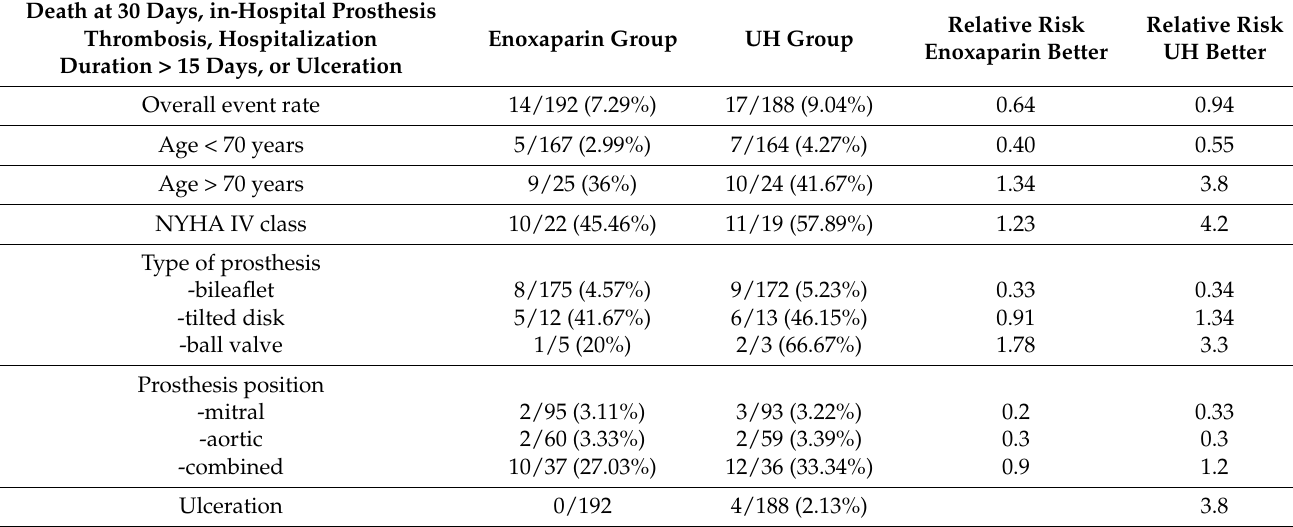
Figure 3. Kaplan–Meier curves for primary endpoints in the study groups. Log ‐ rank tests were highly significant. Early after treatment, the curve for the E started to separate from that of UH, and also, at 48 h, differences between the two groups in the primary endpoints were already present. For the primary efficacy endpoint, the event rates were 6.25% for the E group and 8.51% for the UH group ( p < 0.0001). For the primary ‐ efficacy ‐ plus ‐ safety endpoint, the rates were 6.25% for the E group and 9.04% for the UH group ( p = 0.02). The relative risks in the two groups are presented in Table 5. Table 5. Relative risks and 95% CIs for primary efficacy composite endpoint in the two groups.